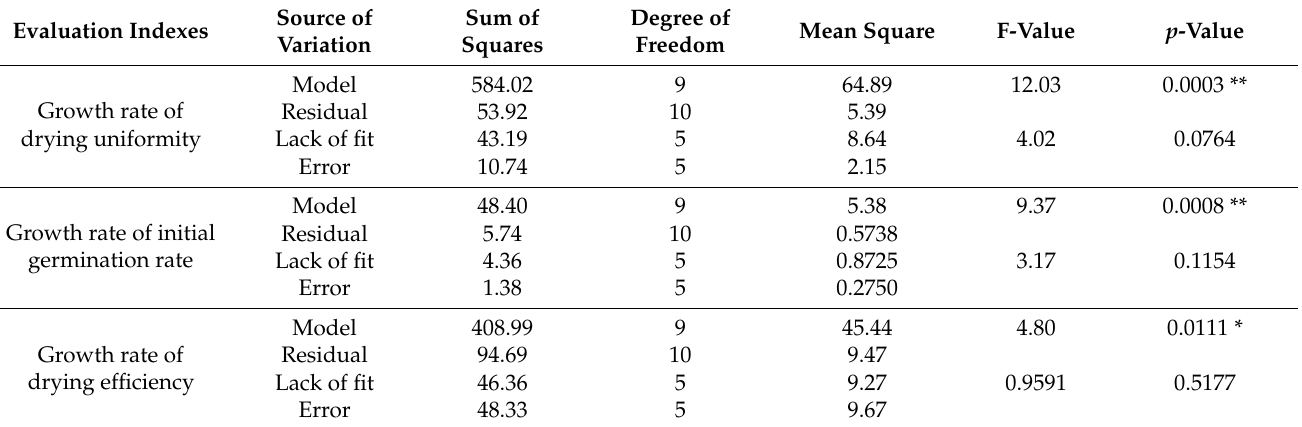
Table 5. Variance analysis of regression